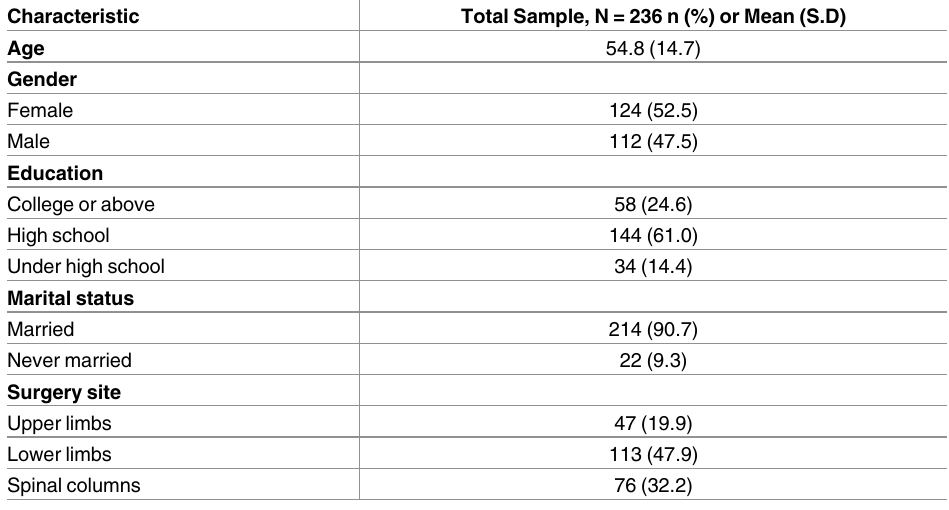
Table 1. Demographic and clinical data of